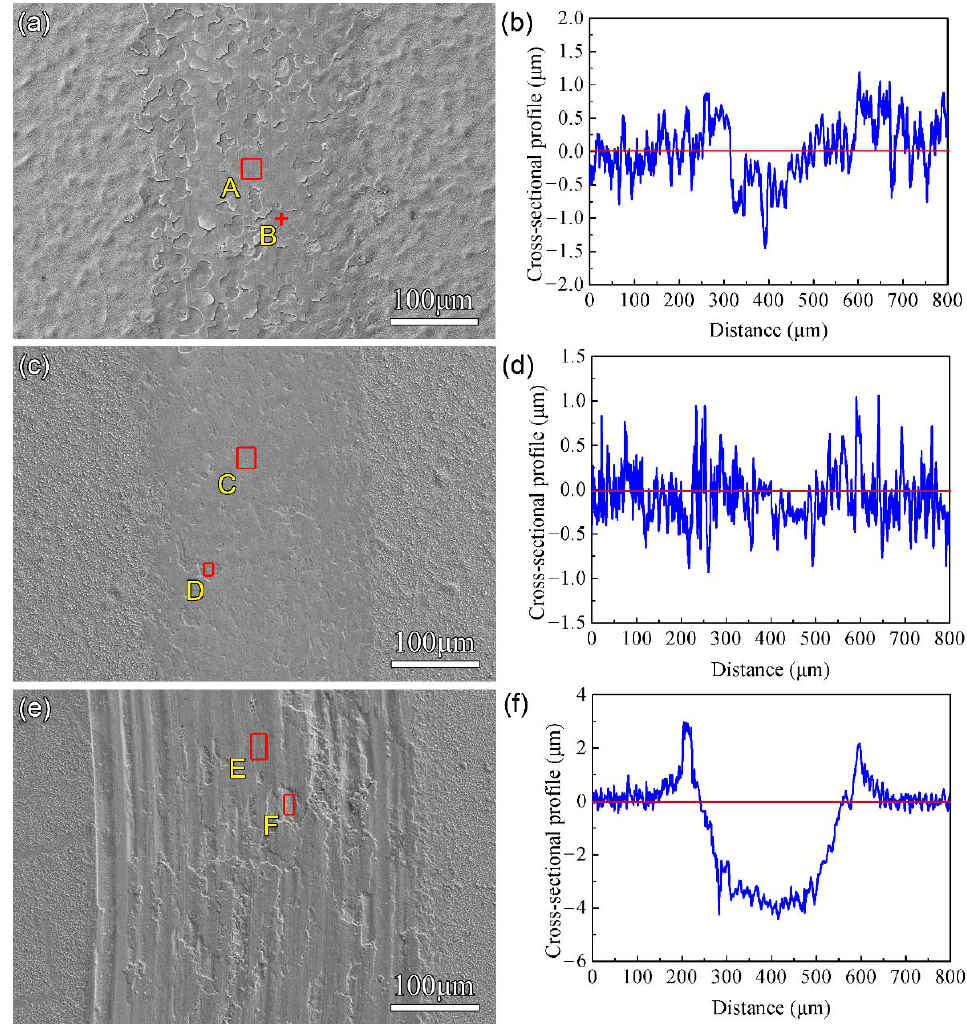
Figure 7. The surface morphology and cross-sectional profile of the worn tracks after plasma nitriding at 650 °C for 4 h: ( a , b ) for F1 film, ( c , d ) for F2 film, ( e , f ) for F3 film.